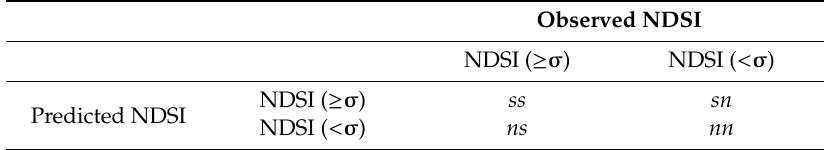
Table 2. Confusion matrix comparing the observed and predicted MODIS binary snow cover